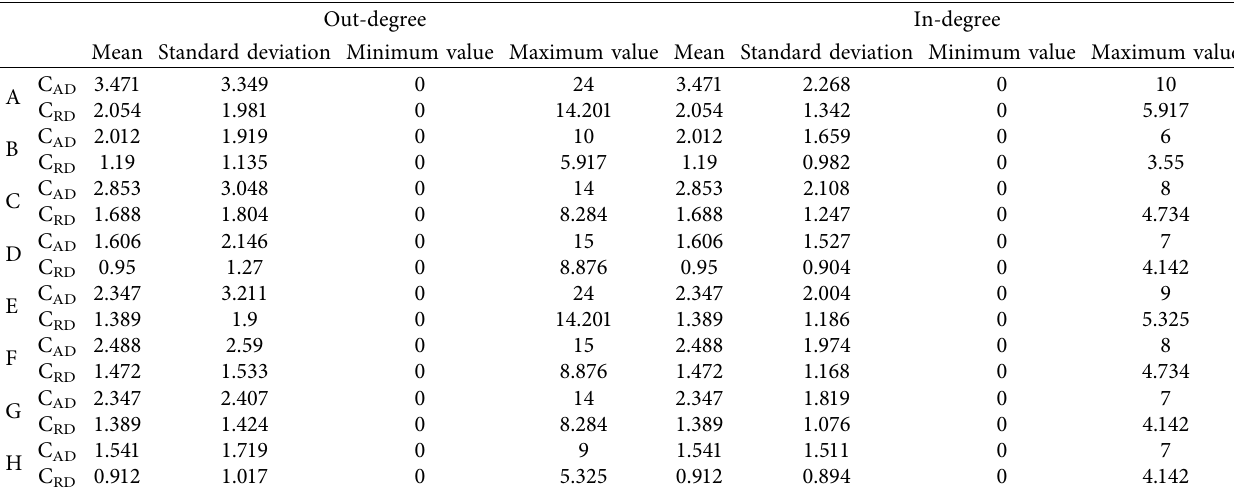
Table 1: Social network degree centrality of professional